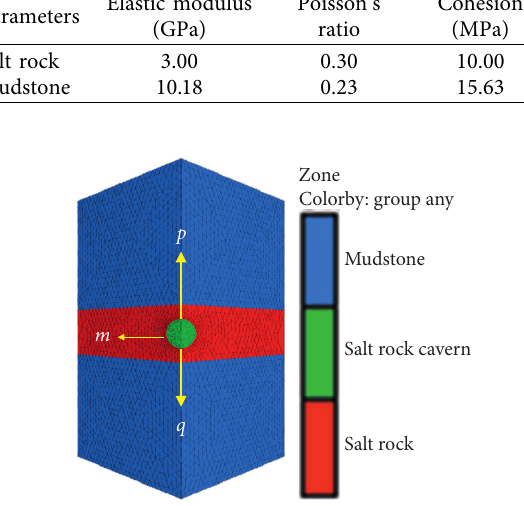
Figure 3: Numerical model of single-cavern horizontal salt rock underground storage ( N �